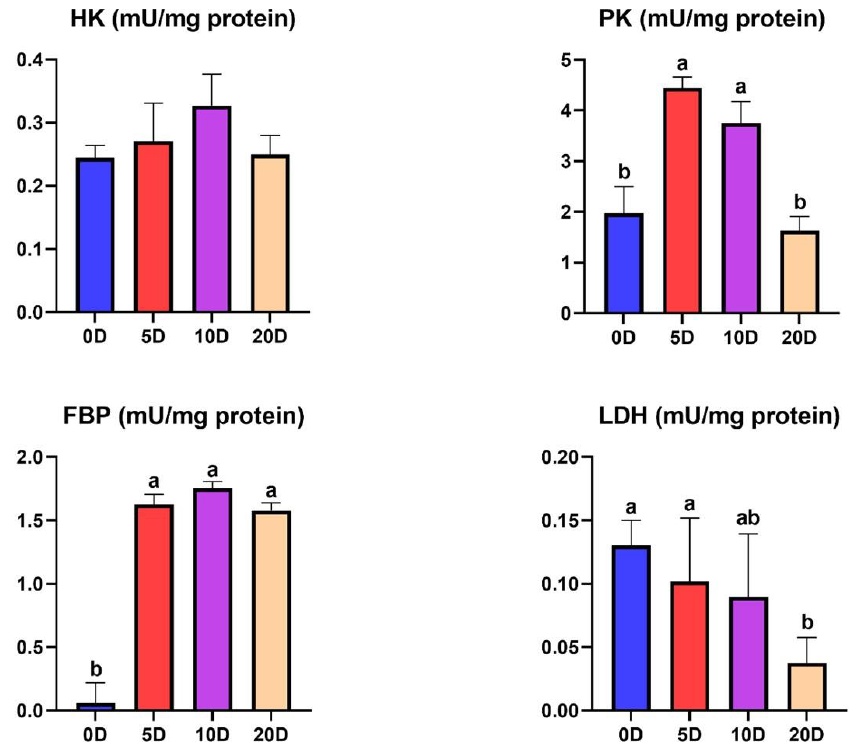
Figure 5. Means ± SEM of the enzyme activities ( n = 18 per treatment) related to glycolytic metabolism in the liver. a, b Different letters indicate significant differences between the pre-slaughter times ( p < 0.05). HK: hexokinase; PK: pyruvate kinase; FBP: fructose 1.6-bisphosphatase; LDH: lactate dehydrogenase. Transformation data for the parameters when performing analysis of variance: LDH (square root). In the transformed variables, the SEM are presented for the transformed data and the means are presented as back-transformed for better interpretation.